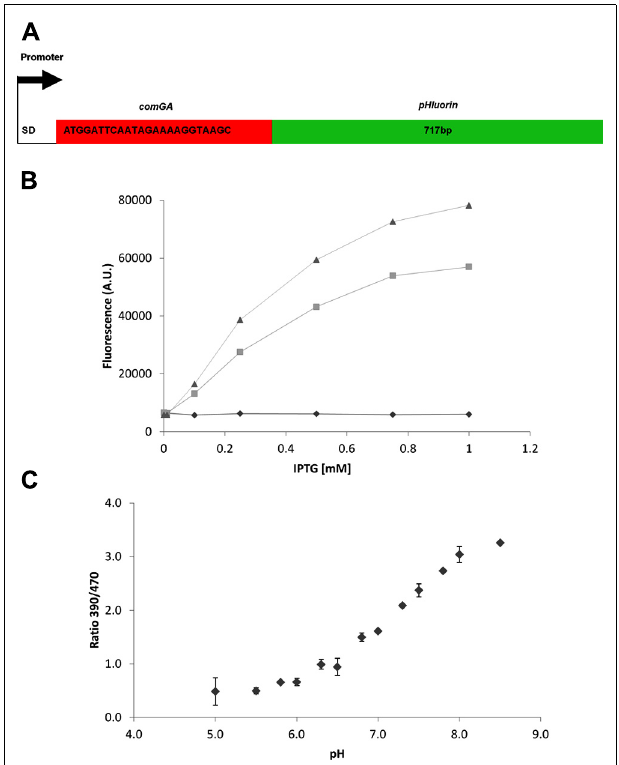
FIGURE 1 | Improved expression of pHluorin in B. subtilis . (A) Schematic overview of the improved pHluorin construct. SD – Shine–Dalgarno sequence. comGA – the first 24 bp of comGA , with the start codon converted to ATG. (B) Expression levels of pHluorin and improved pHluorin after induction with IPTG. Fluorescence (AU, arbitrary units) at 510 nm from excitation at 390 nm was measured after 2.5 h of induction and normalized to OD 600 . Diamonds, control (pDG148); squares, pHluorin (pDG-pHluorin); triangles, IpHluorin (pDG-IpHluorin). (C) Calibration curve for IpHluorin. Error bars indicate standard deviations ( n = 3).